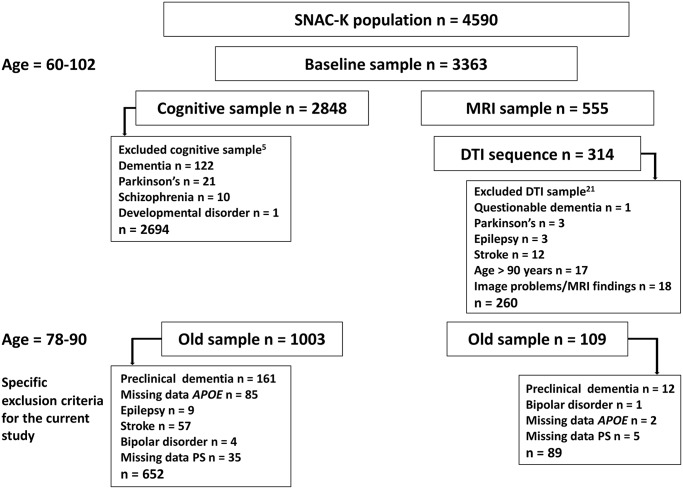
Number of participants and exclusion criteria for the total sample and the DTI subsample.SNAC-K = Swedish National study on Aging and Care in Kungsholmen, MRI = magnetic resonance imaging, DTI = diffusion tensor imaging, APOE = apolipoprotein E, PS = perceptual speed.